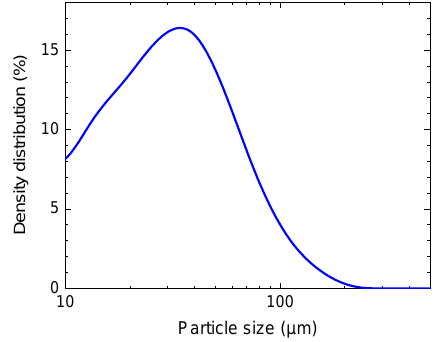
Figure 1. Particle size distribution of lactose powder used in this study.